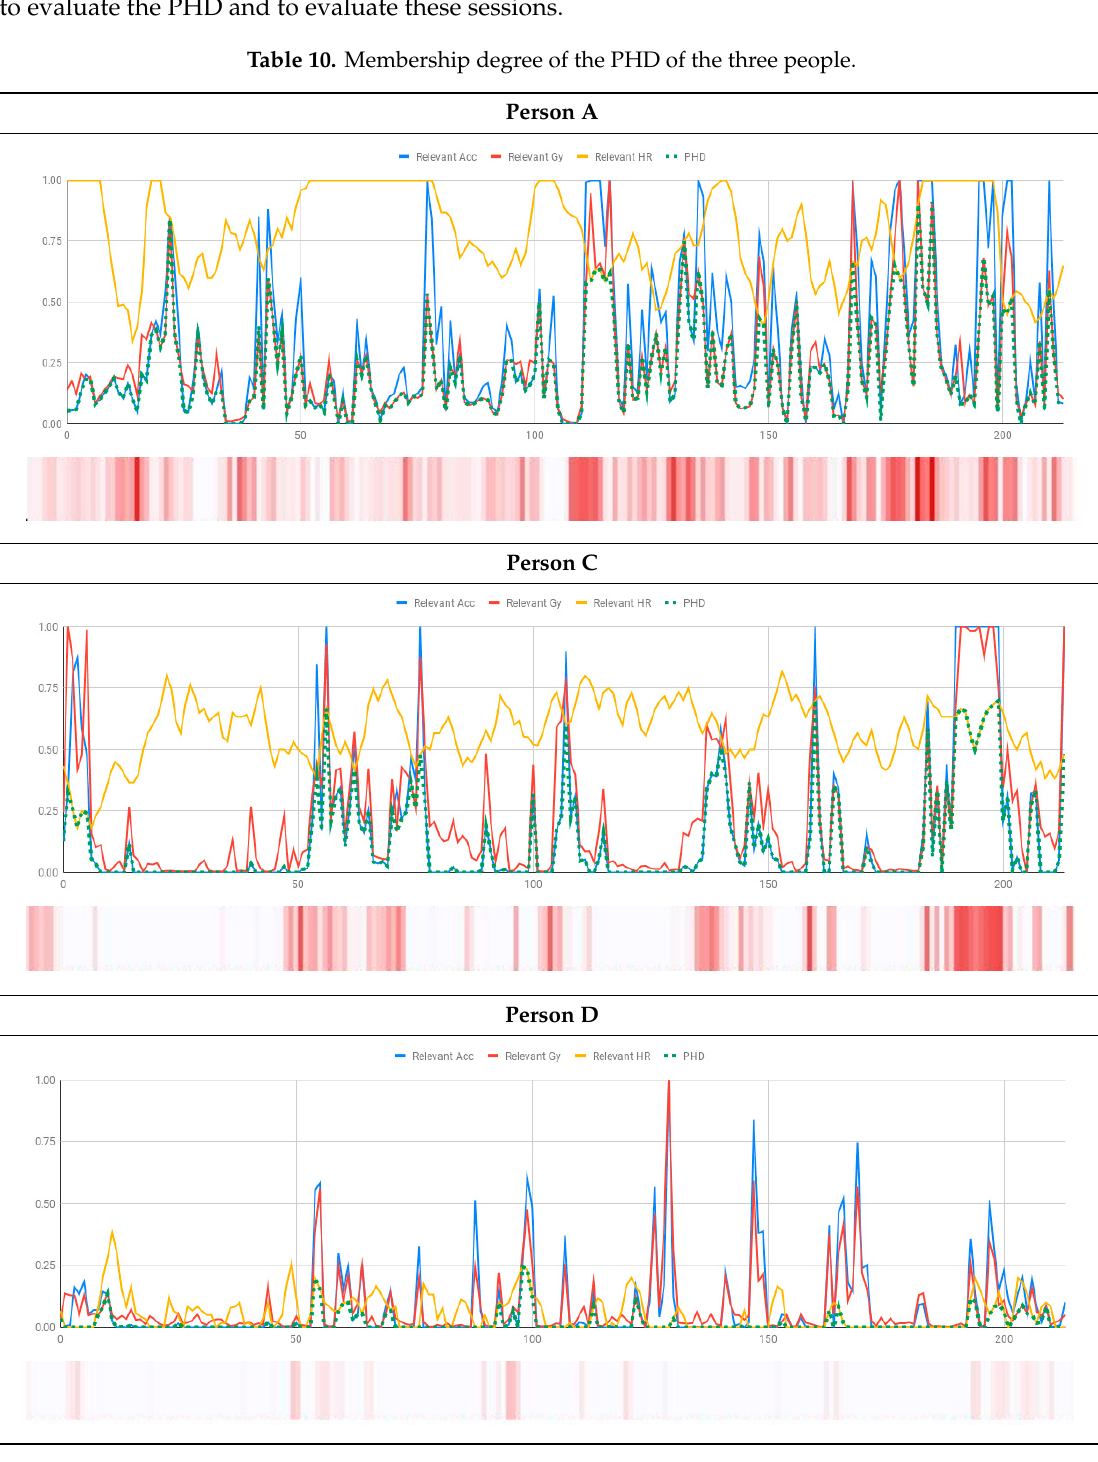
Table 10. Membership degree of the PHD of the three people.